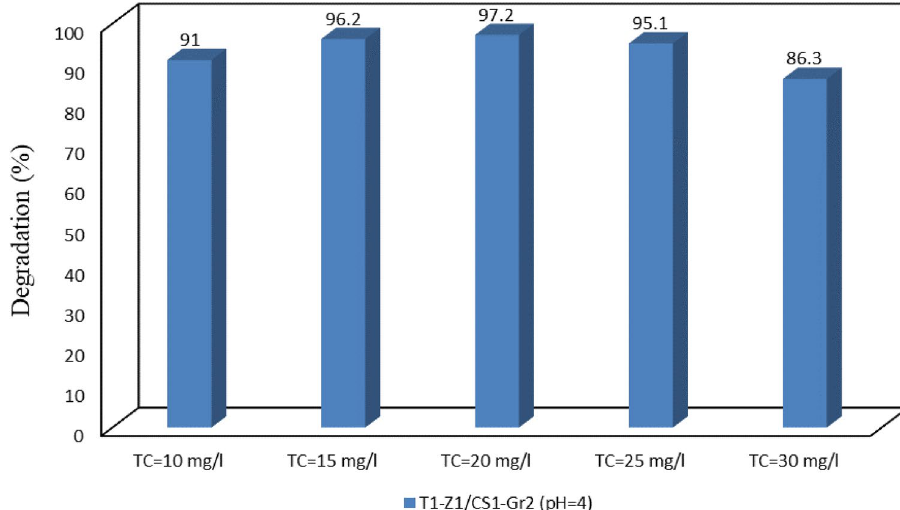
Figure 10. Photodegradation of TC with different concentrations at optimal pH.